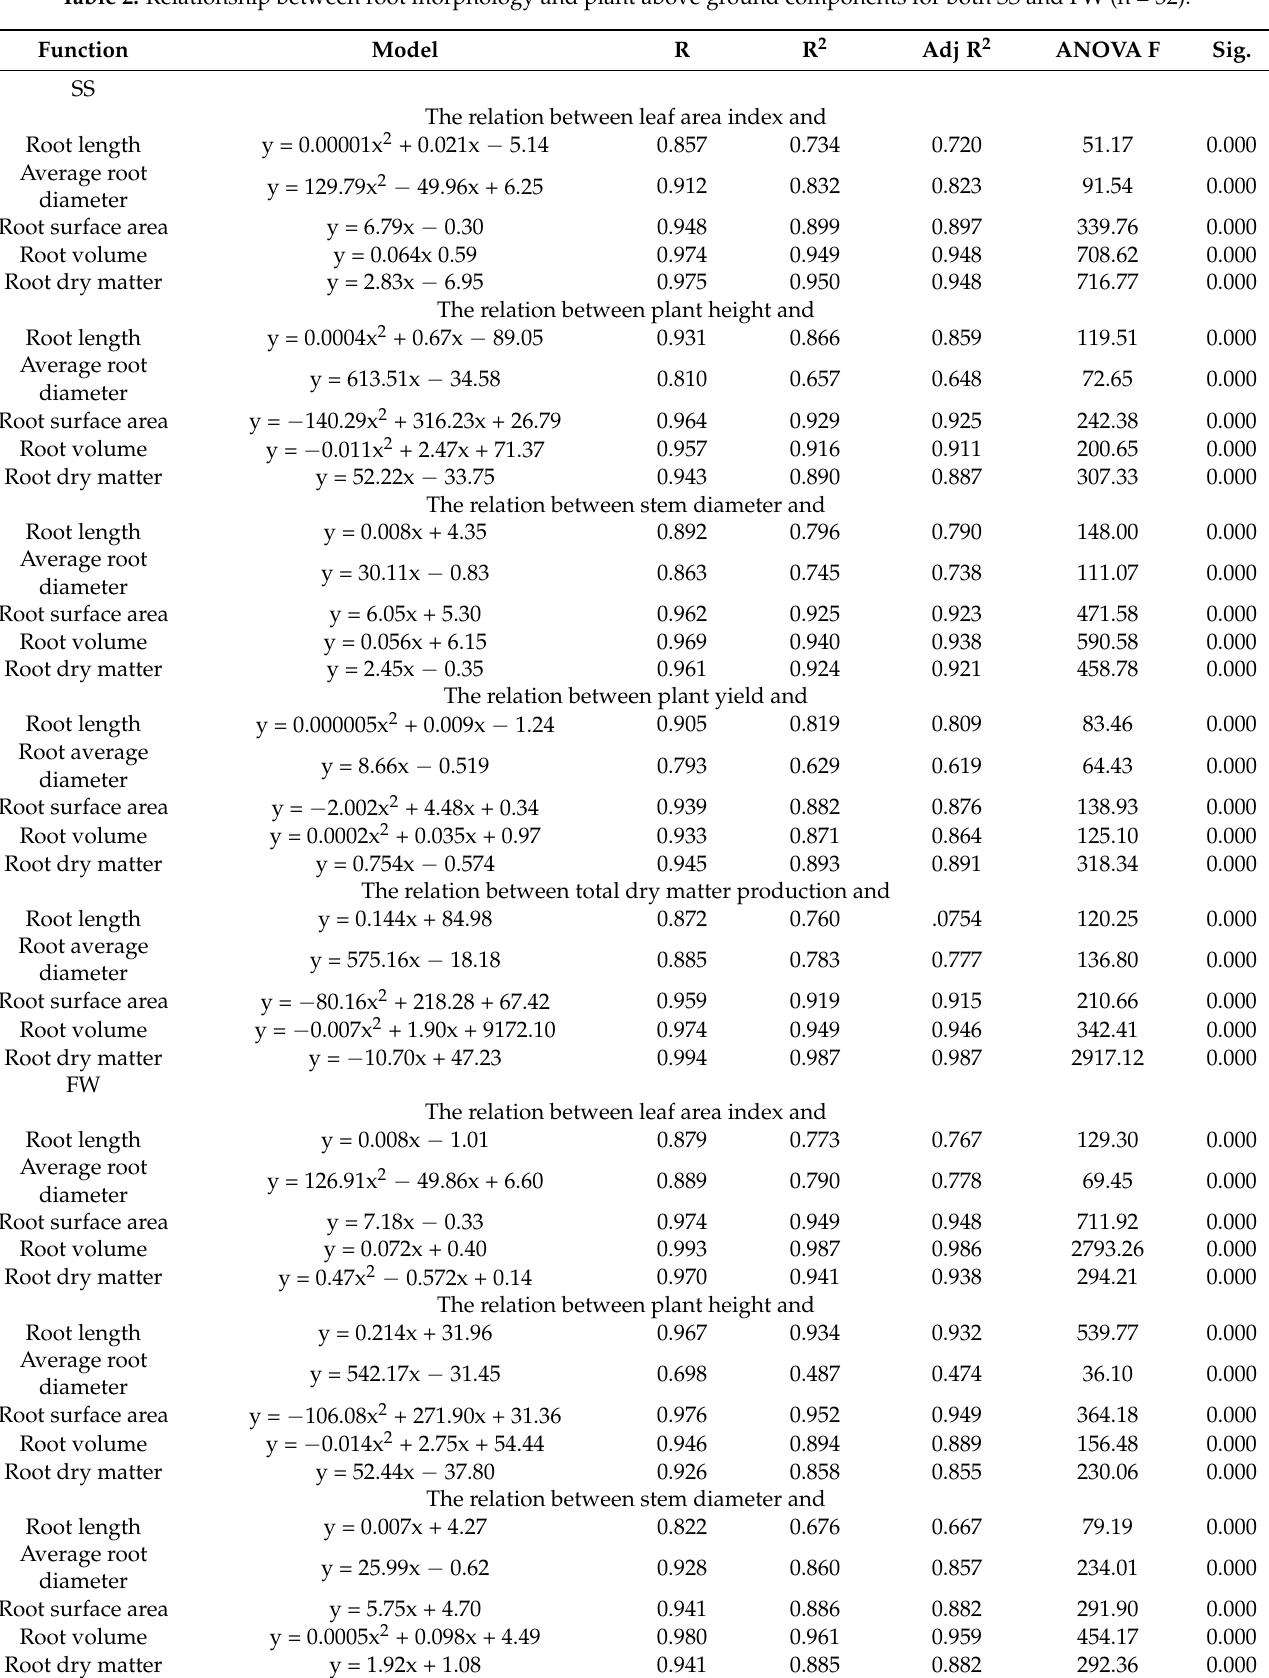
Table 2. Relationship between root morphology and plant above ground components for both SS and FW (n = 32). Function